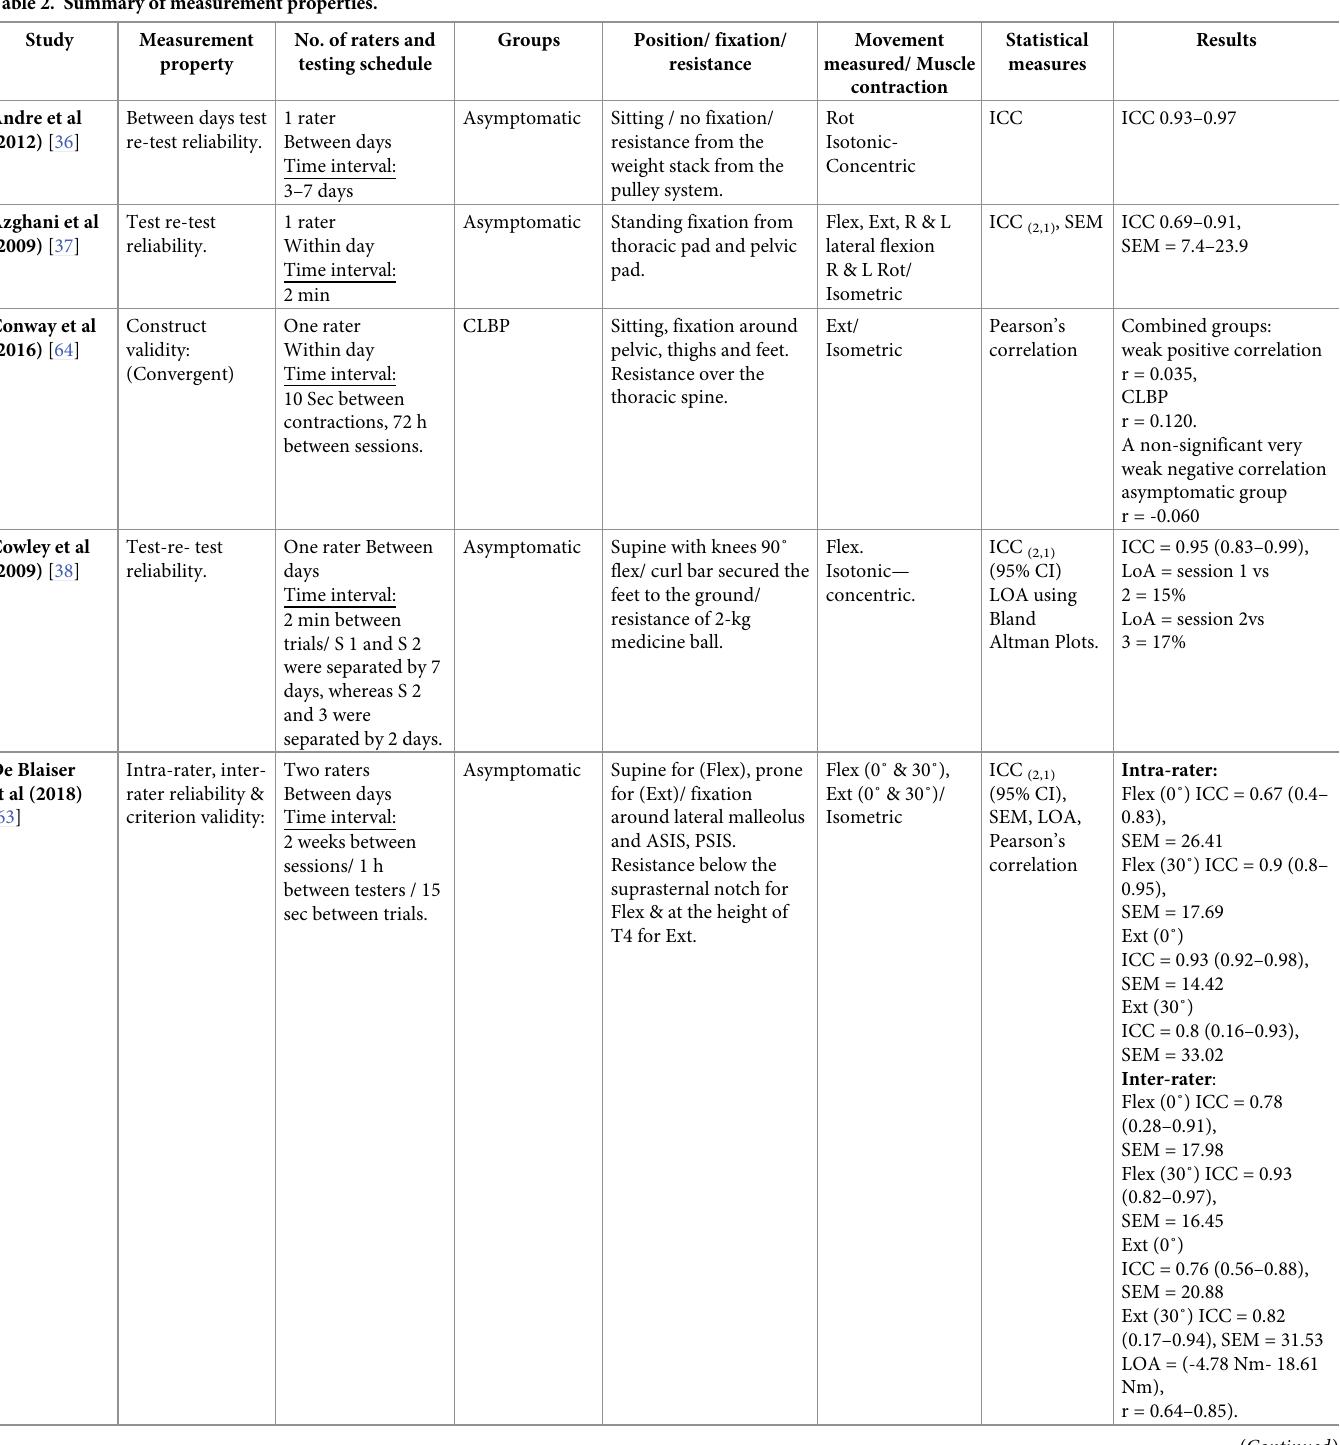
Table 2. Summary of measurement